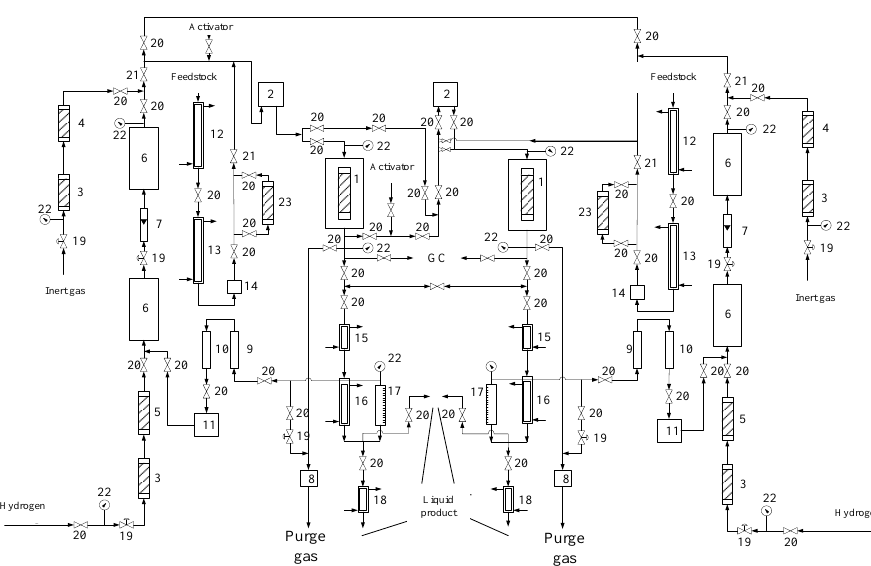
Figure 4. Simplified scheme of the experimental apparatus (1 reactor; 2 pre-heater; 3 oxygen transformer; 4, 5 gas dryer; 6, 10 gas-filter; 7 gas-flow meter; 8 gas-flow meter; 9 drop-holder; 11 compressor; 12, 13 feedstock vessel; 14 pump; 15, 18 cooler; 16 separator; 17 level detector; 19 controlling valve; 20 blocking valve; non-return valve; 22 pressure indicator; 23 feedstock dryer. Table 1. The main characteristics of light biogasoline fractions.